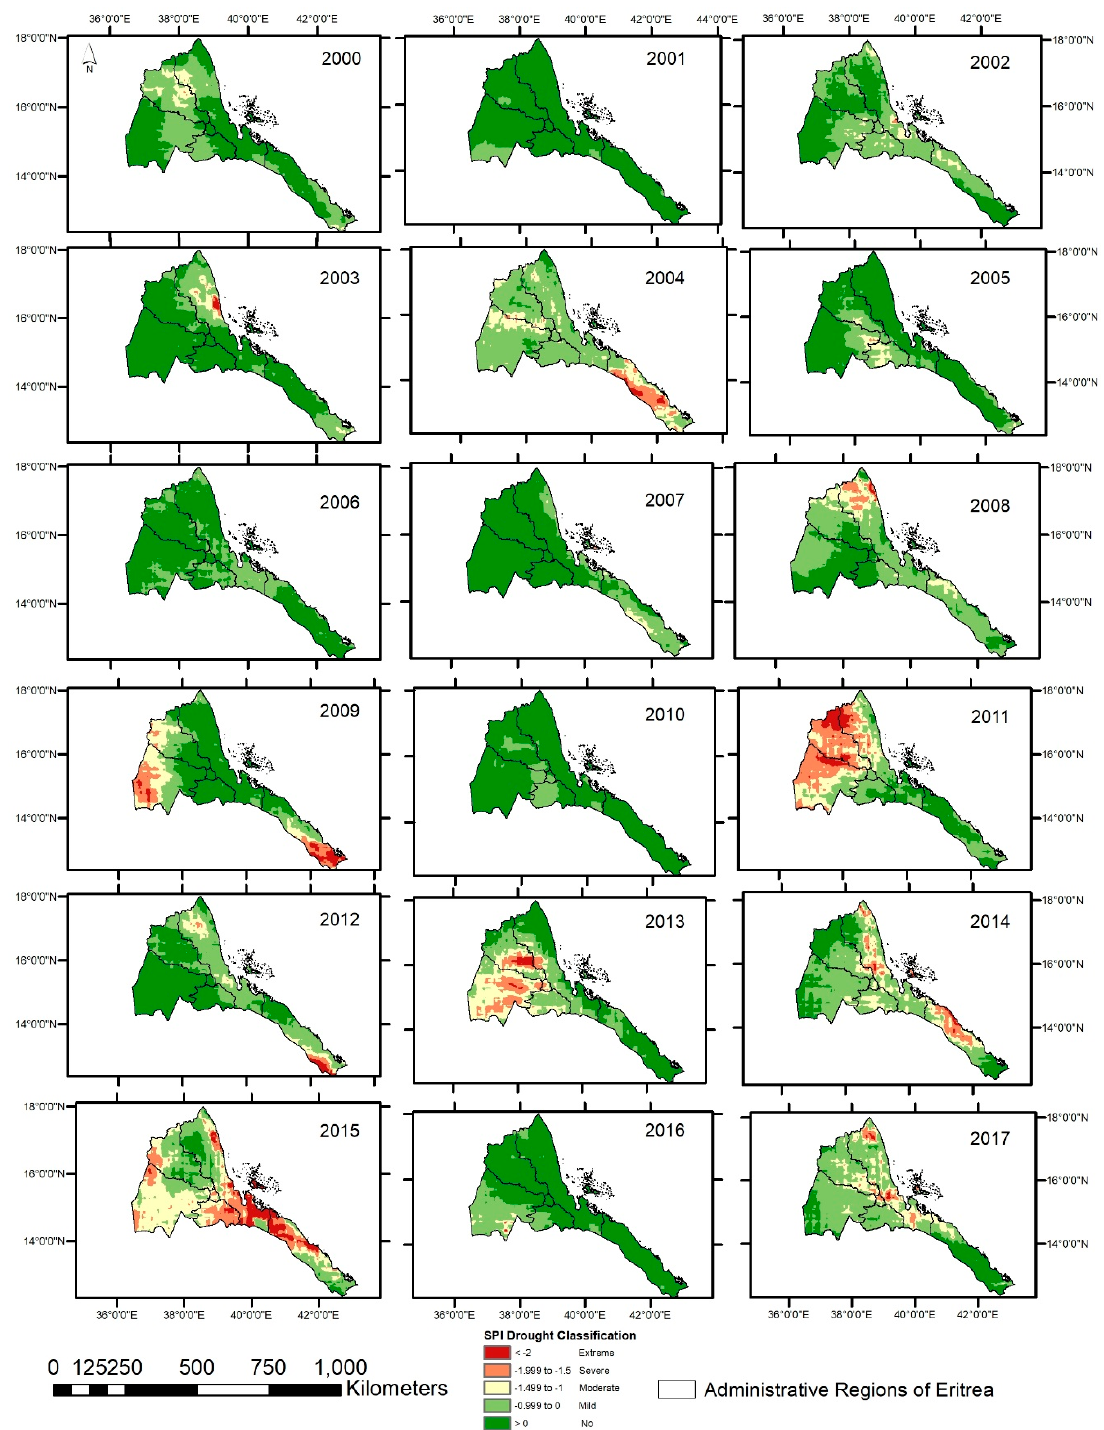
Figure 11. Aggregated SPI-4 drought conditions in Eritrea during 2000 – 2017.